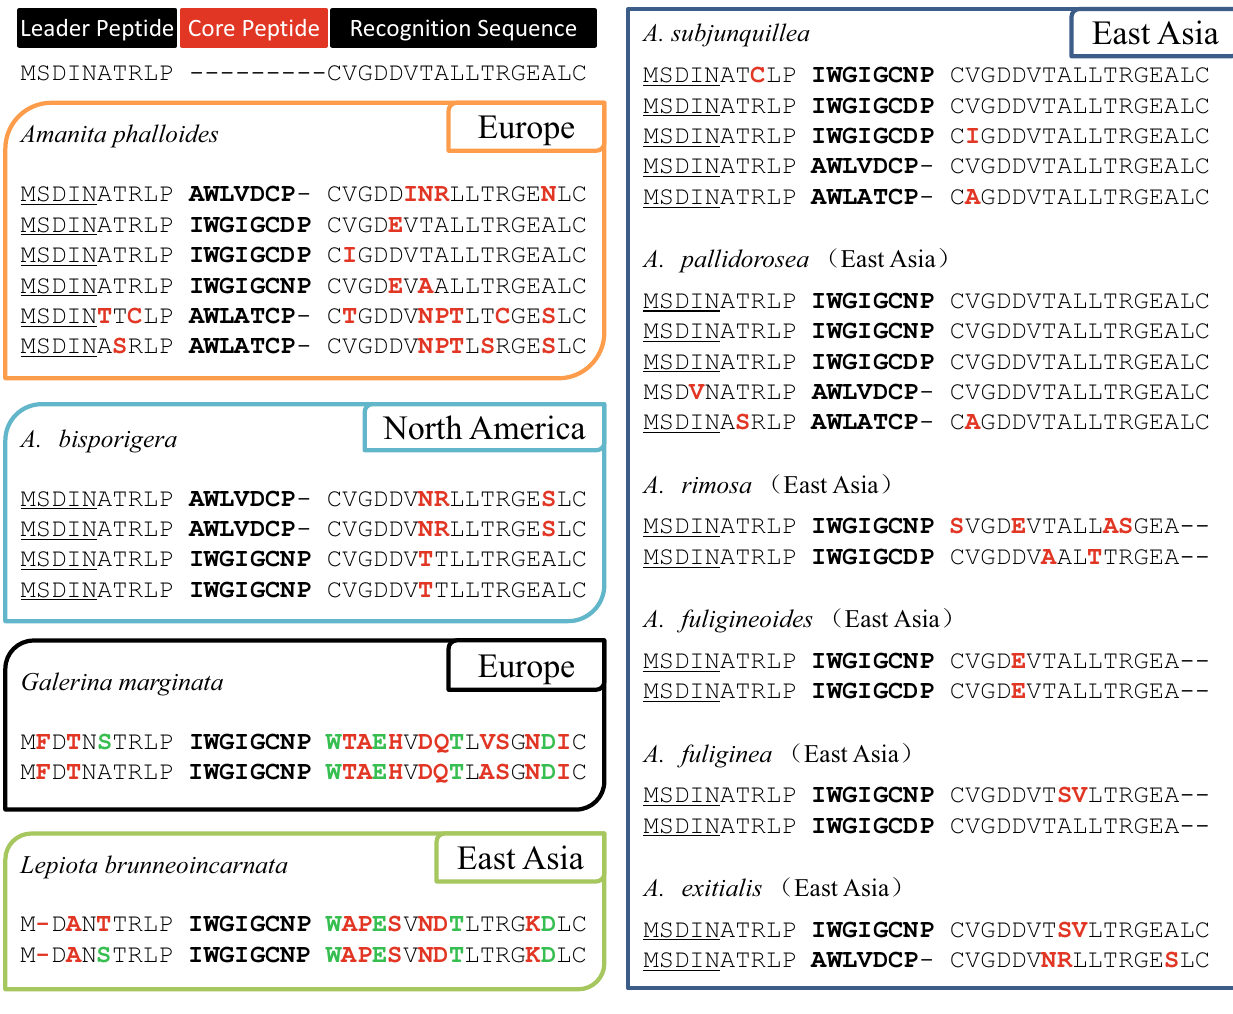
Fig. 2. (cid:2)q’(cid:13)(cid:10)’(cid:11)(cid:13)(cid:15)(cid:2)(cid:4)(cid:26)(cid:2)>F^(cid:128)|(cid:2)(cid:26)(cid:9)(cid:6)(cid:11)(cid:23)(cid:22)(cid:2)(cid:25)(cid:13)(cid:17)(cid:13)(cid:7)(cid:2)(cid:11)(cid:17)(cid:2)(cid:8)(cid:14)(cid:13)(cid:2)(cid:8)(cid:14)(cid:10)(cid:13)(cid:13)(cid:2)(cid:9)(cid:6)(cid:9)(cid:17)(cid:11)(cid:8)(cid:11)(cid:17)#(cid:18)(cid:10)(cid:4)(cid:21)(cid:5)(cid:19)(cid:11)(cid:17)(cid:25)(cid:2)(cid:9)(cid:25)(cid:9)(cid:10)(cid:11)(cid:19)(cid:2)(cid:25)(cid:13)(cid:17)(cid:13)(cid:10)(cid:9)(cid:28)(cid:2)](cid:18)(cid:18)(cid:13)(cid:10)(cid:2)(cid:23)(cid:13)(cid:26)(cid:8)(cid:2)(cid:11)(cid:17)(cid:21)(cid:11)(cid:19)(cid:9)(cid:8)(cid:13)(cid:7)(cid:2)(cid:8)(cid:14)(cid:13)(cid:2)(cid:12)(cid:13)(cid:7)(cid:8)(cid:2)(cid:10)(cid:13)(cid:18)(cid:10)(cid:13)(cid:7)(cid:13)(cid:17)(cid:8)(cid:13)(cid:21)(cid:2)(cid:19)(cid:4)(cid:17)(cid:7)(cid:13)(cid:17)(cid:7)(cid:5)(cid:7)(cid:2) sequence, with a general schematic structure of MSDIN genes with leader peptide, core peptide, and recognition sequence (not including the (cid:19)(cid:4)(cid:10)(cid:13)(cid:2)(cid:18)(cid:13)(cid:18)(cid:8)(cid:11)(cid:21)(cid:13)(cid:29)(cid:2)(cid:8)(cid:14)(cid:13)(cid:2)(cid:14)(cid:22)(cid:18)(cid:13)(cid:10)’(cid:9)(cid:10)(cid:11)(cid:9)(cid:12)(cid:23)(cid:13)(cid:2)(cid:10)(cid:13)(cid:25)(cid:11)(cid:4)(cid:17)(cid:27)(cid:28)(cid:2)V(cid:4)(cid:23)(cid:4)(cid:5)(cid:10)(cid:13)(cid:21)(cid:2)(cid:12)(cid:4)&(cid:13)(cid:7)(cid:2)(cid:14)(cid:9)(cid:10)(cid:12)(cid:4)(cid:10)(cid:2)(cid:7)(cid:18)(cid:13)(cid:19)(cid:11)(cid:13)(cid:7)(cid:2)(cid:26)(cid:10)(cid:4)(cid:6)(cid:2)(cid:7)(cid:18)(cid:13)(cid:19)(cid:11)(cid:20)(cid:19)(cid:2)(cid:25)(cid:13)(cid:4)(cid:23)(cid:4)(cid:25)(cid:11)(cid:19)(cid:9)(cid:23)(cid:2)(cid:23)(cid:4)(cid:19)(cid:9)(cid:8)(cid:11)(cid:4)(cid:17)(cid:7)(cid:28)(cid:2)V(cid:4)(cid:23)(cid:4)(cid:5)(cid:10)(cid:13)(cid:21)(cid:2)(cid:24)(cid:10)(cid:13)(cid:21)(cid:2)(cid:9)(cid:17)(cid:21)(cid:2)(cid:25)(cid:10)(cid:13)(cid:13)(cid:17)(cid:27)(cid:2)(cid:23)(cid:13)(cid:8)(cid:8)(cid:13)(cid:10)(cid:7)(cid:2) indicate variations (differences) compared with the consensus sequence. In G. marginata and L. brunneoincarnata , green letters also designate conserved amino acids only between the two species. MSDIN sequences are underlined, and true MSDIN sequences are only found in Amanita species.